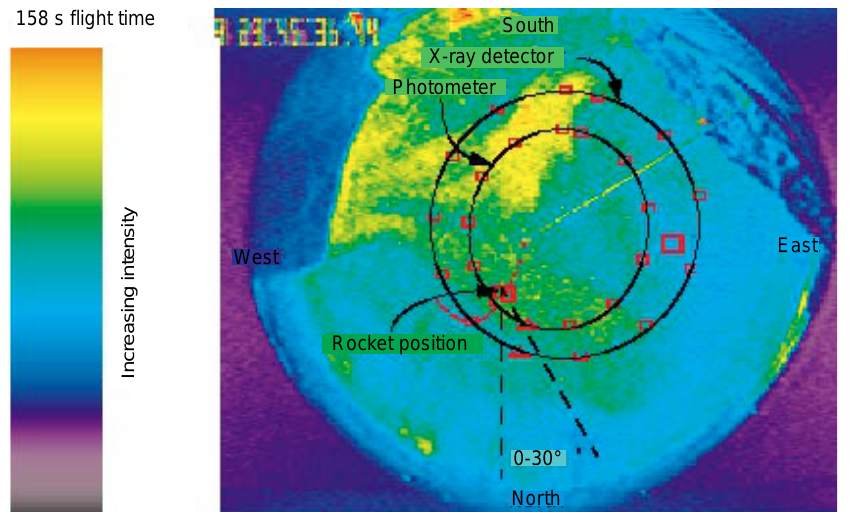
Fig. 3. All-sky TV picture at 158-s flight time. Projections down to the horizontal production layer are indicated for the scanning paths of the X-ray detector and the photometers, and down along the field line for the rocket position. The yellow streak in SE is produced by a lidar beam. The small red squares are the centre field of view at each centre time of data accumu- lation for the photometer and the X-ray detector. The large red square indicates the location